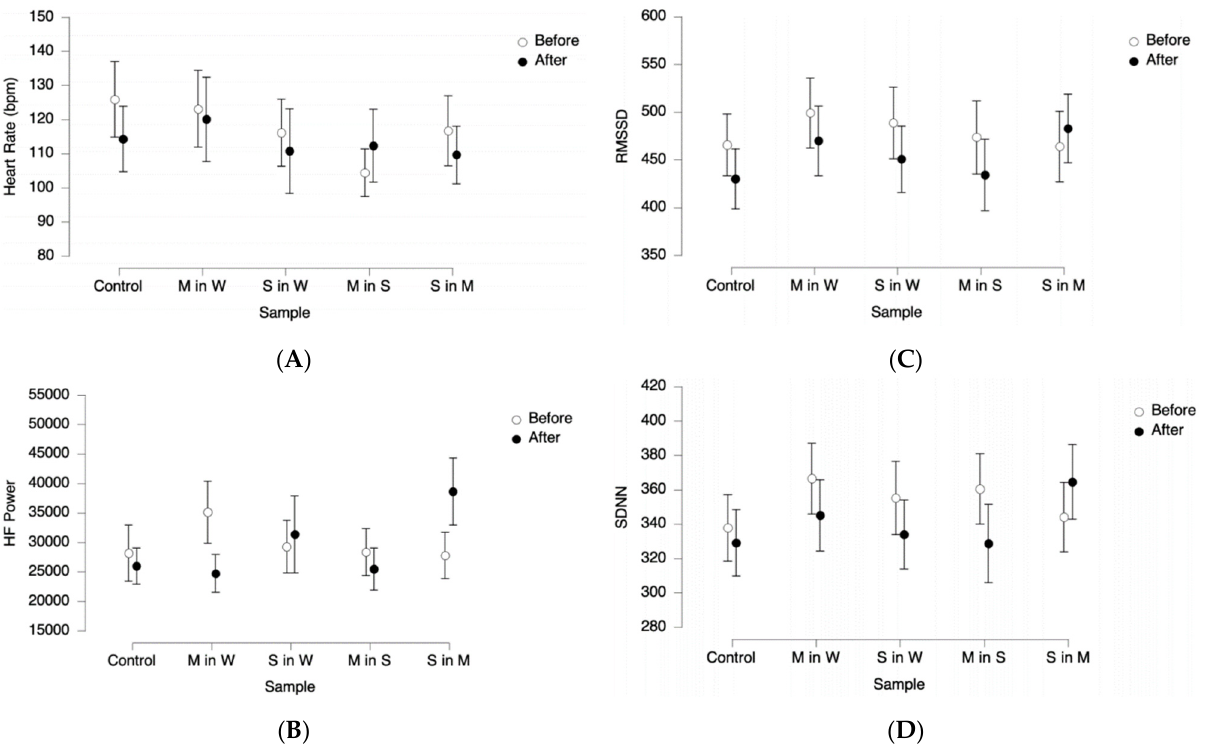
Figure 5. Unconscious responses of 32 participants to samples containing menthol (M in W), sucrose in water (S in W), menthol in sucrose solution (M in S), and sucrose in menthol solution (S in M). Measured responses were heart rate ( A ), the high frequency power band ( B ), the root mean sum of squared distance ( C ), and the standard deviation of the NN interval ( D ).